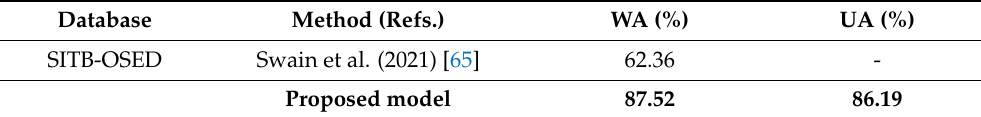
Table 7. Performance (%) comparison between our proposed method and a state-of-the-art method on the